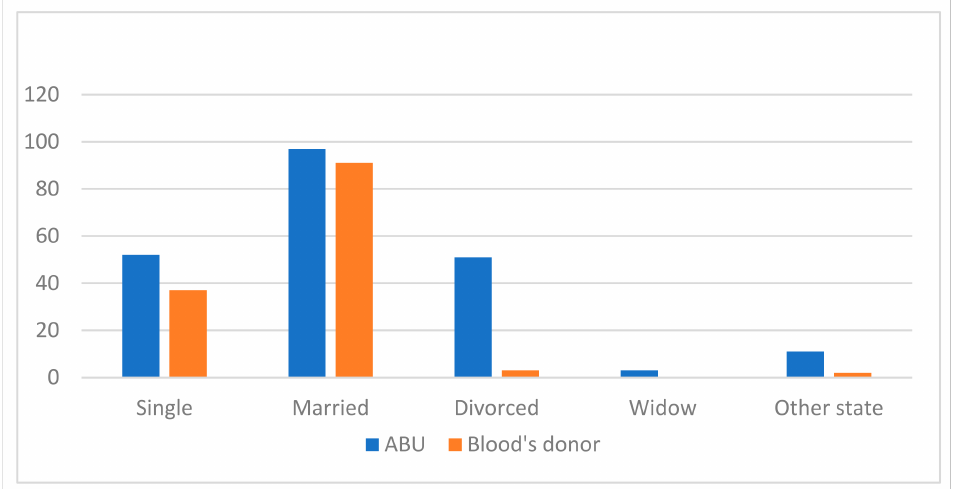
Figure 2. Comparison of marital status for both groups, ABU and blood